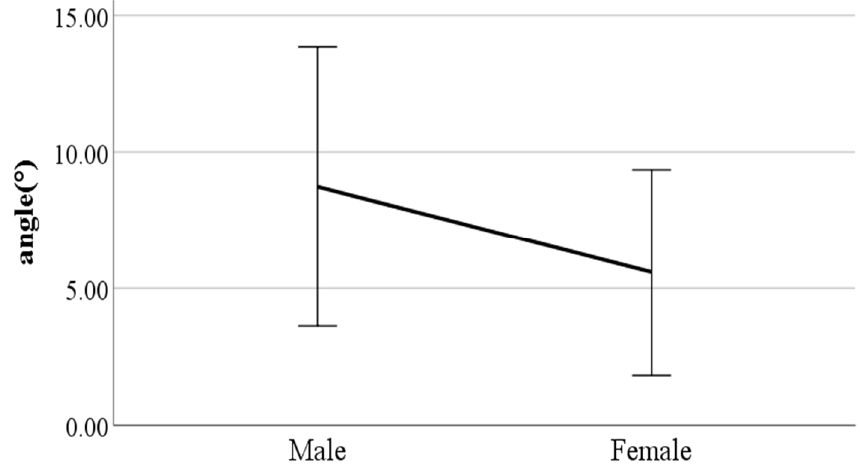
Figure 14. Gender difference in mean flexion of the spinal column in the sagittal plane (F value: 24.67, DF: 289, p -value: 0.00).